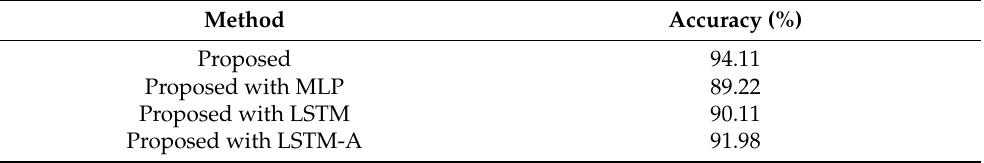
Table 3. The downstream regressor performance benchmark (T = 5 days).